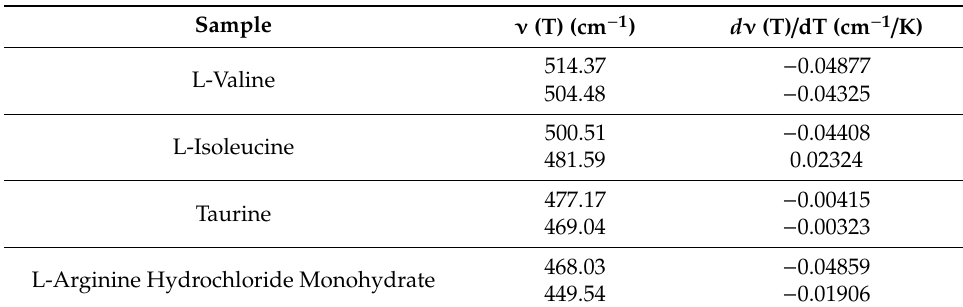
Table 1. Parameters of the linear fitting for wavenumber thermal evolution of the Raman bands, ν (T) (cm − 1 ) and d ν (T) / dT (cm − 1 / K), associated with NH 3 + torsional vibration for L-valine, L-isoleucine, taurine, and L-arginine hydrochloride monohydrate crystals.